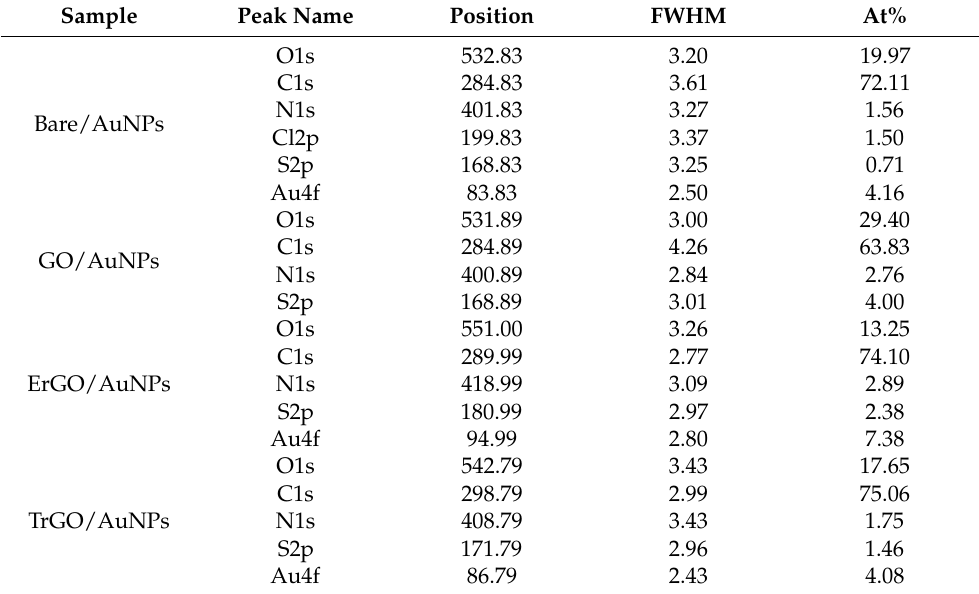
Table A3. Detailed information for the XPS peaks, their position, the FWHM, and the At% for a bare electrode after the deposition of the AuNPs and electrodes modified with GO/AuNPs, ErGO/AuNPs, and TrGO/AuNPs. These data are obtained from XPS survey scans (Figure 4).